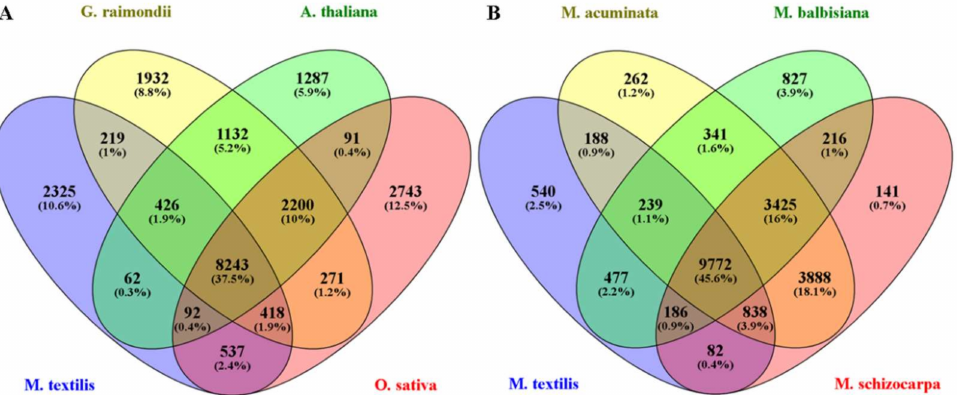
Figure 4. Venn diagram showing the number of orthologous groups. ( A ) The common and unique orthologous groups among M. textilis , G. raimondii , A. thaliana and O. sativa . ( B ) The common and unique orthologous groups among M. textilis , M. acuminata , M. balbisiana and M. schizocarpa . Orthofinder’s multiple sequence alignment, using MAFFT and RAxML, generated a species tree comprising the Musa textilis var. Abuab peptide sequence, and the seven down- loaded peptide sequences from Gramene-Ensembl Biomart. A total of 2507 orthogroups